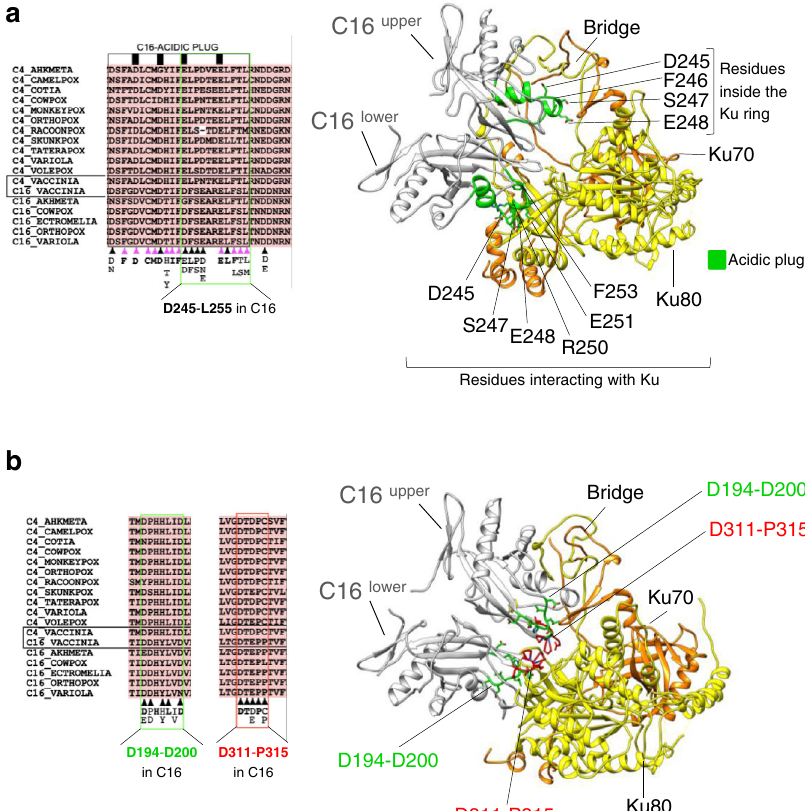
Fig. 7 | Conservation of regions in C4/C16 involved in the interaction with Ku. a Leftpanel: multiple amino acid sequencealignment ofC4 and C16 proteins from the poxviridae family (Supplementary Fig. 9a for details). Amino acids involved in interactions with Ku are marked with fi lled triangles and those conserved in the acidic plug but not directly involved in the interaction with Ku are marked with a pink triangle. The predominant amino acid found at each site of interaction is also shown, with those shown in bold text indicating absolute/strong conservation of